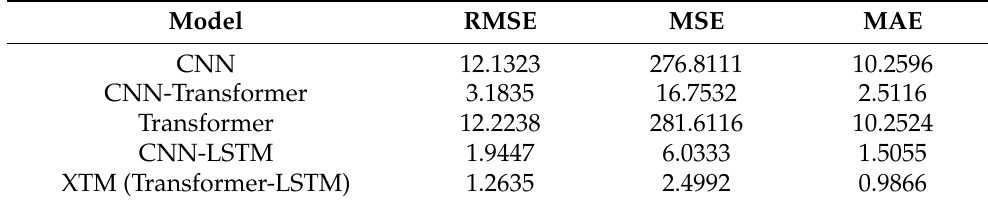
Table 5. Loss of forecasting module.